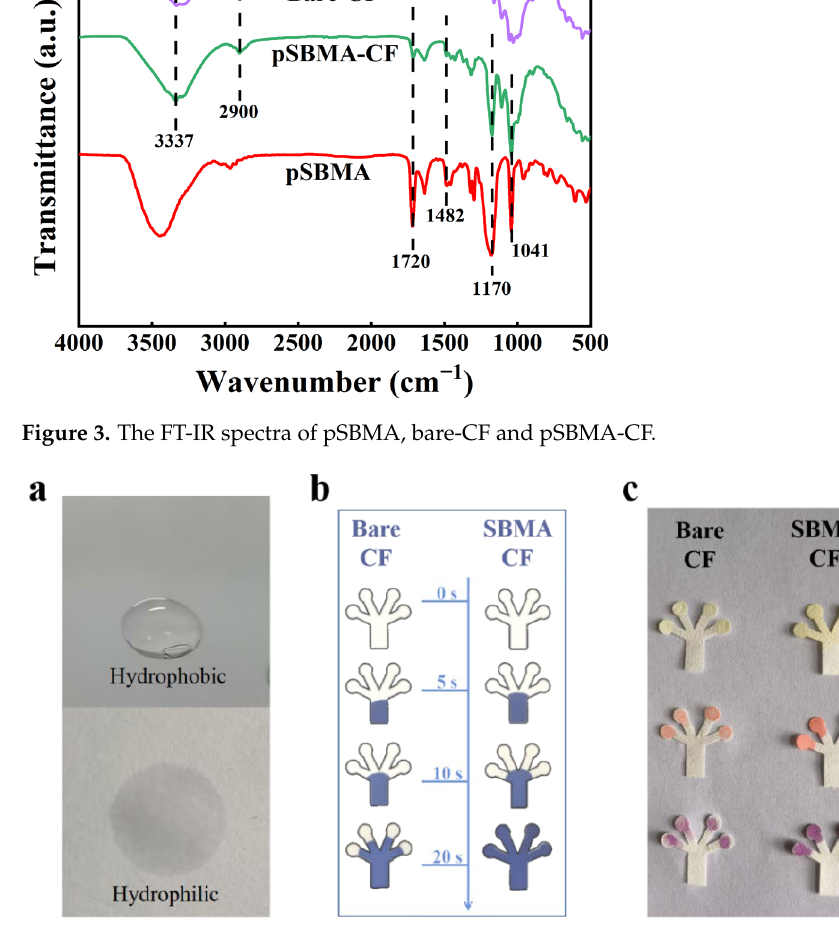
Figure 4. ( a ) Water dropped onto hydrophobic and hydrophilic zones; ( b ) the time dependence of the adsorption of blue ink on bare-CF and pSBMA-CF, respectively; ( c ) the detection of chlorpyrifos, profenofos and cypermethrin using bare-CF and pSBMA-modified CF.